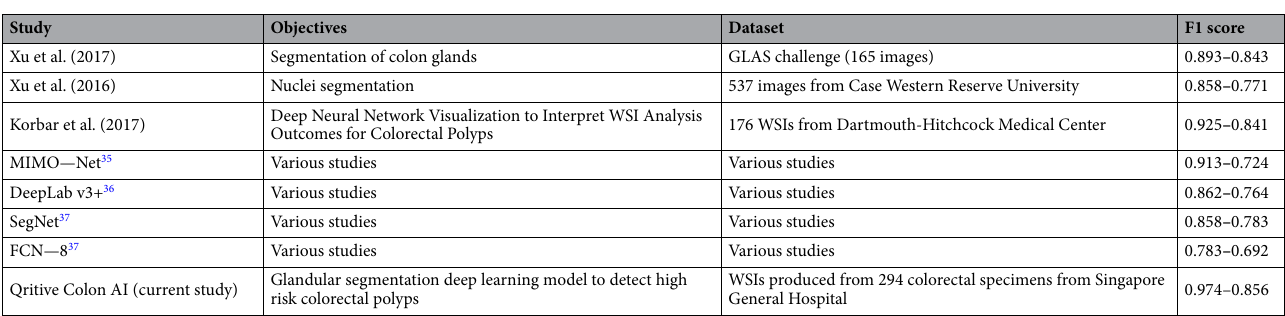
Table 2. Comparison of studies with similar convolutional neural network architecture. GLAS Gland Segmentation in Colon Histology Images Challenge Contest, WSI whole slide